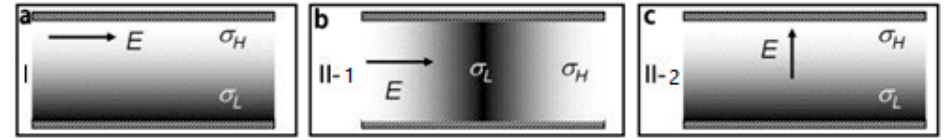
Figure 2. Typical base states for electro-kinetics with type I ( a ); type II-1 ( b ); and type II-2 ( c ). E and the arrow indicate the electric field and its direction, respectively; σ H and σ L indicate high- and low- conductivity regions, respectively. Reproduced with permission from [72].